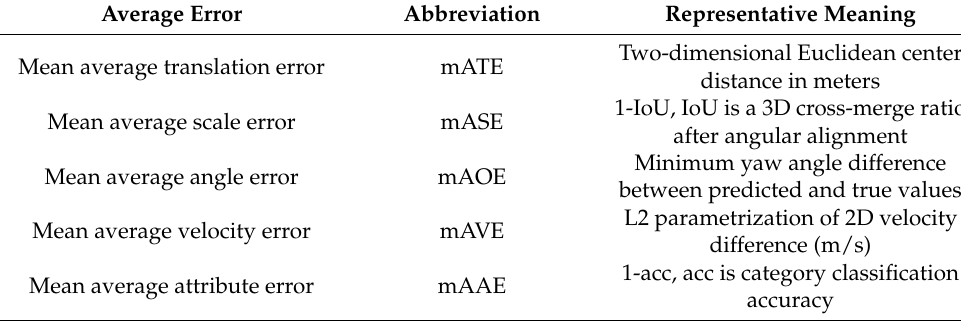
Table 1. Meaning of each average error index. Average Error Abbreviation Representative Meaning Mean average translation error mATE Mean average scale error Mean average angle error mAOE Mean average velocity error mAVE